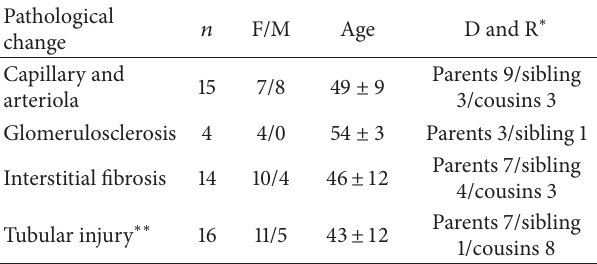
Table 2: Pathological changes of donor